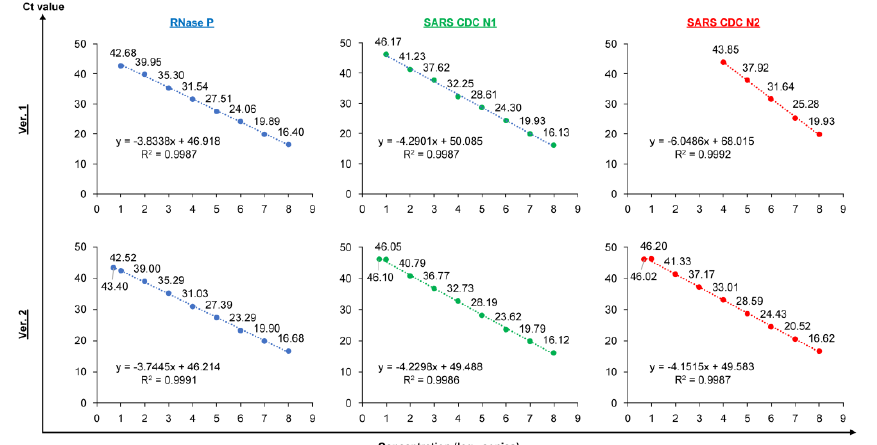
Figure 1. The correlation of each concentration of synthetic RNA and cycle threshold (Ct) value when the PCR1100 device was utilized to detect with multichannel of the old and new versions. Ver. 1 denotes the old version (qPCR condition: annealing/amplification temperature was 60°C). Ver. 2 denotes the new version (qPCR condition: annealing/amplification temperature was 63°C). The Ct value against each concentration is demonstrated by the number above each symbol. x : log 10 copies; y : Ct value.